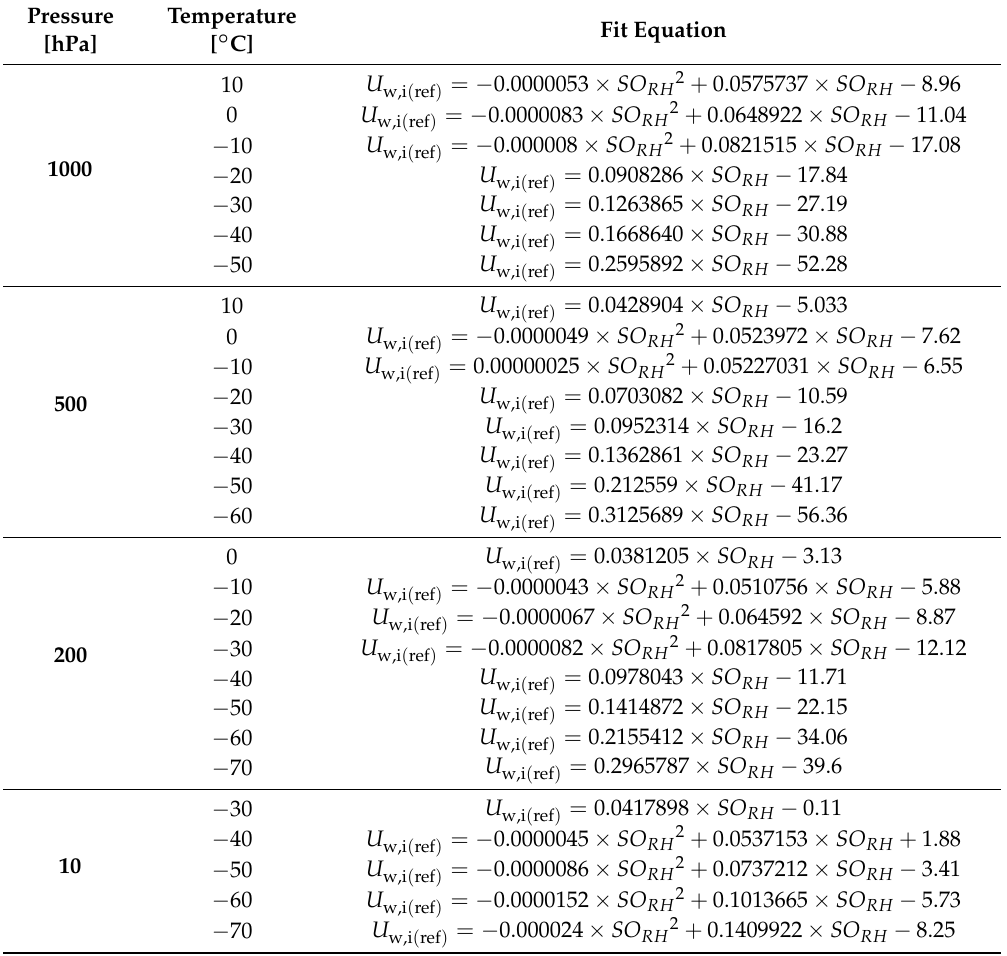
Table 2. Polynomial (quadratic) and linear regression fit equations for each pressure–temperature pair shown in Figures 1a–i and